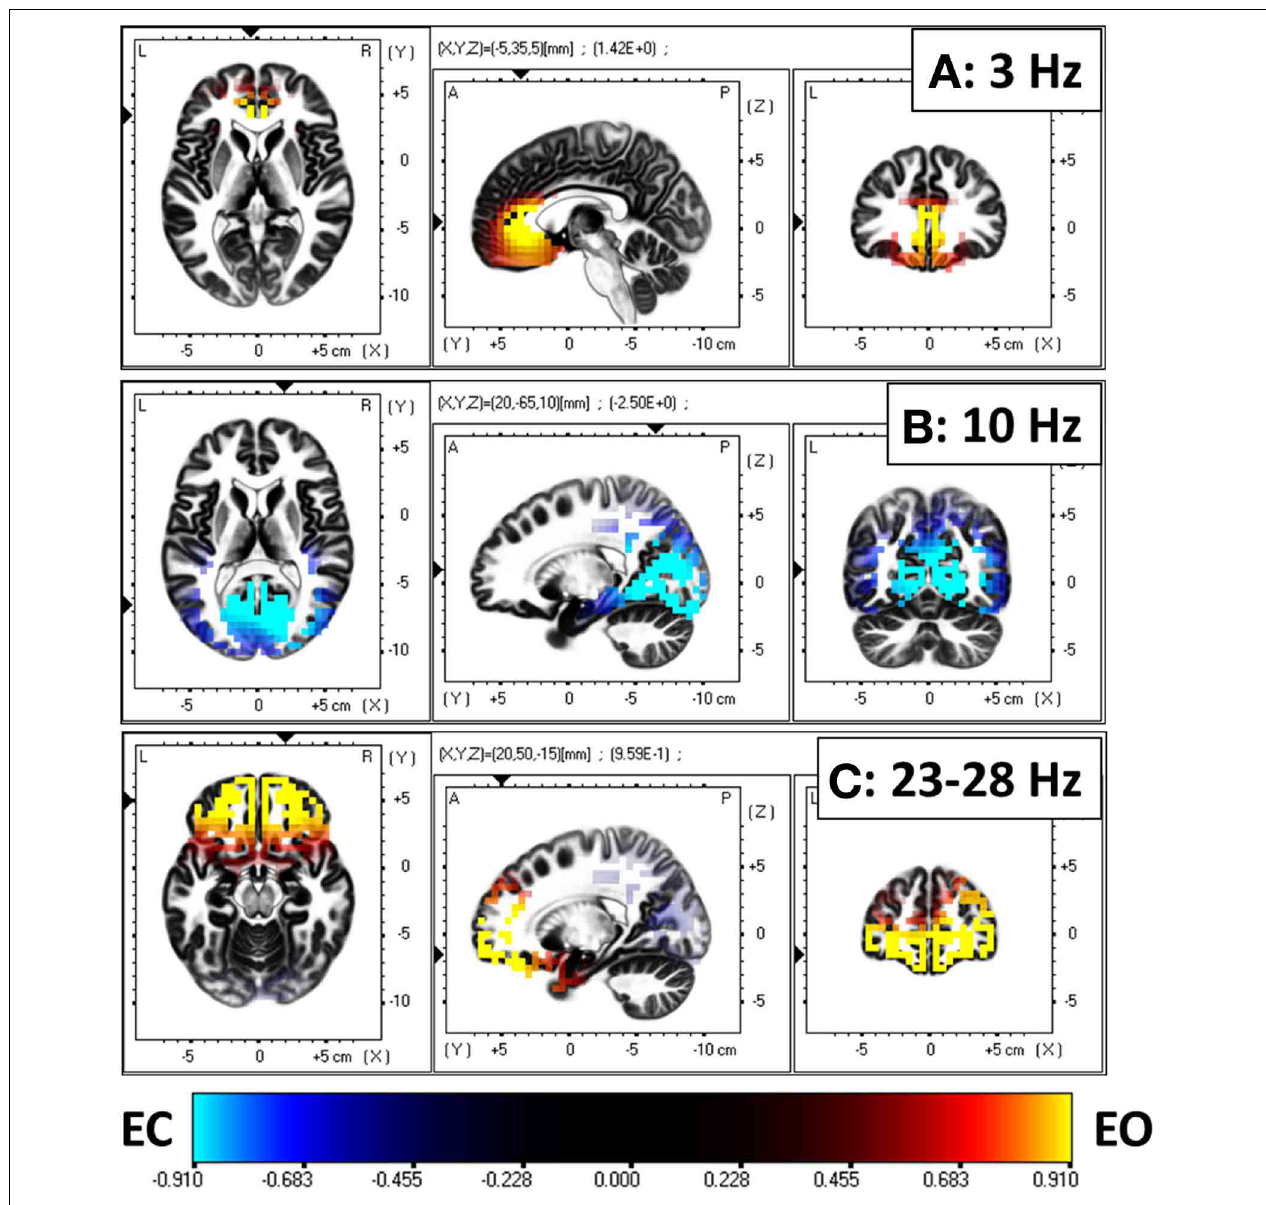
FIGURE 6 | Comparison of electric neuronal activity (eLORETA) between eyes open and closed conditions. A Log-F-ratio statistic with correction for multiple testing was used, with corrected p = 0 . 05 at LogF = 0.91. Eyes open is characterized by significantly